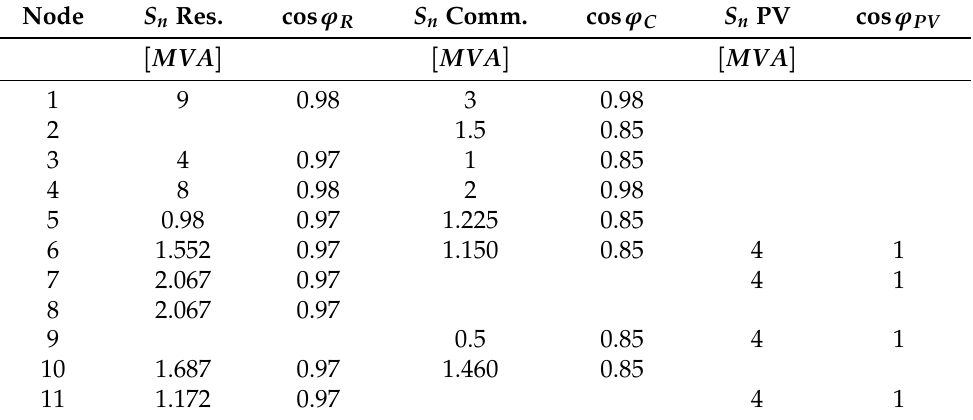
Table 9. PV and loads data.